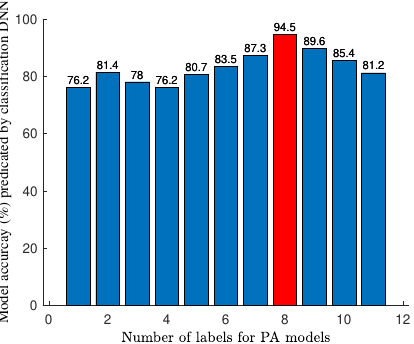
Figure 4. Accuracy prediction of 11 models using the classification